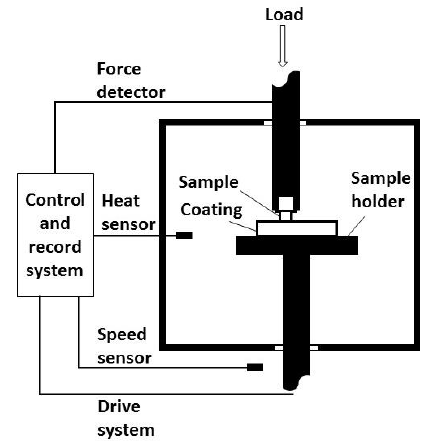
Figure 1. Schematic diagram of the high-temperature sliding